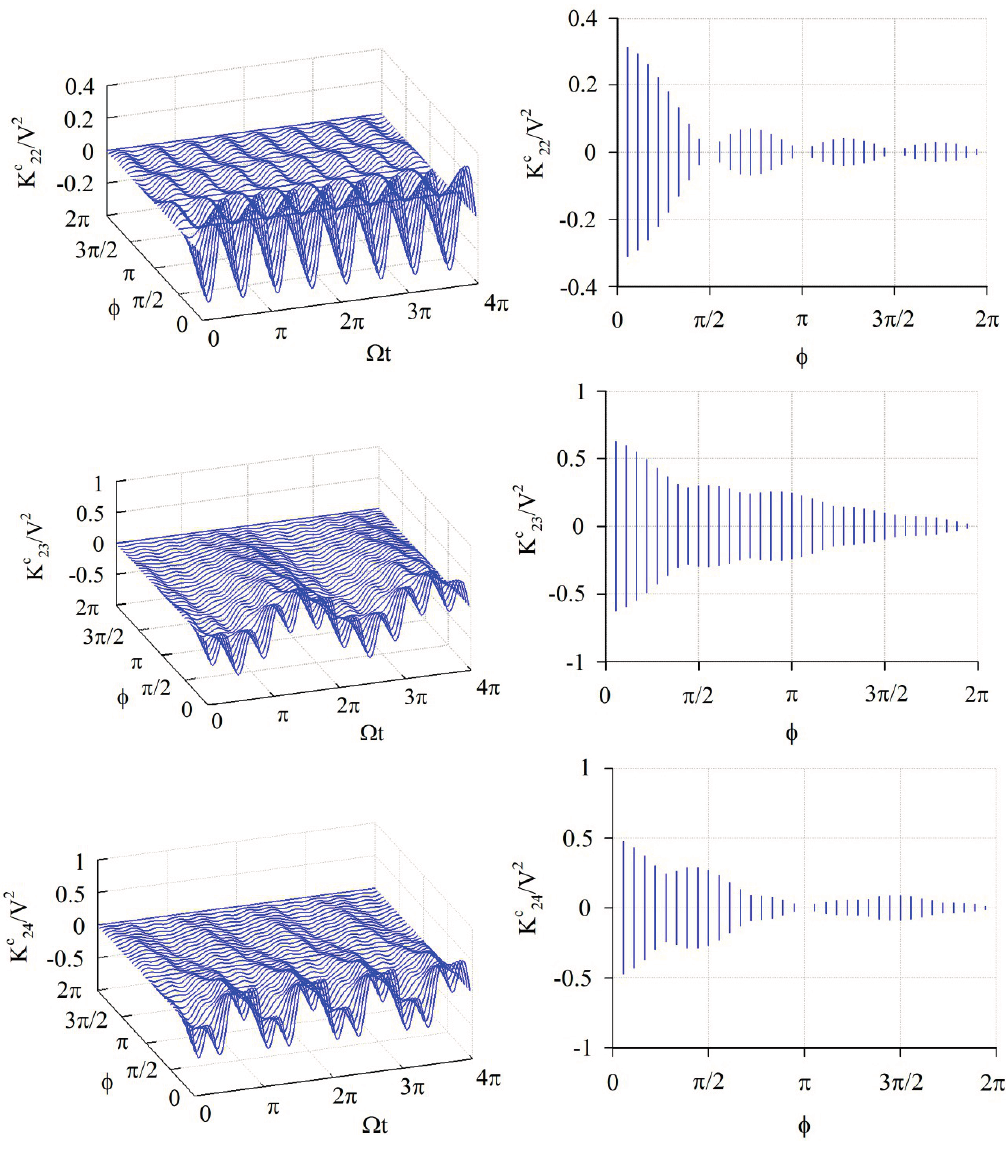
Figure 5. The numerical results of some feature elements ( 2 of the c -partition of stiffness matrix. The graphs at the right-hand side are the projections of the graphs at the left-hand side on the plane containing ϕ -axis and K